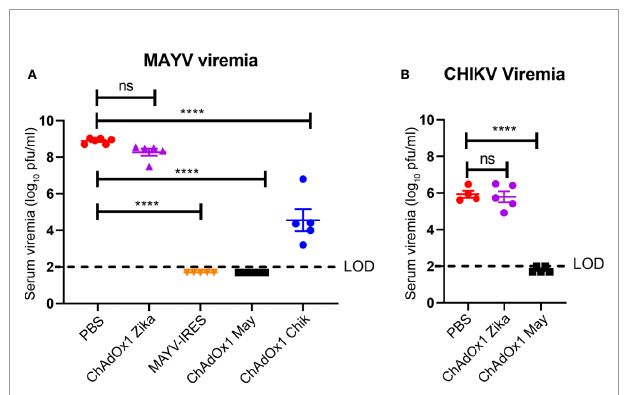
FIGURE 4 | ChAdOx1 May and ChAdOx1 Chik vaccines afford cross-protection by reducing viremia. Blood was collected 2 days post challenge and serum was titrated. (A) Mayaro virus (MAYV) viremia. (B) Chikungunya virus (CHIKV) viremia. The limit of detection (LOD) is 2 log 10 PFU/ml. Data represented as mean and SEM, one-way ANOVA with Dunnett ’ s, ****p < 0.0001. ns, not signi fi